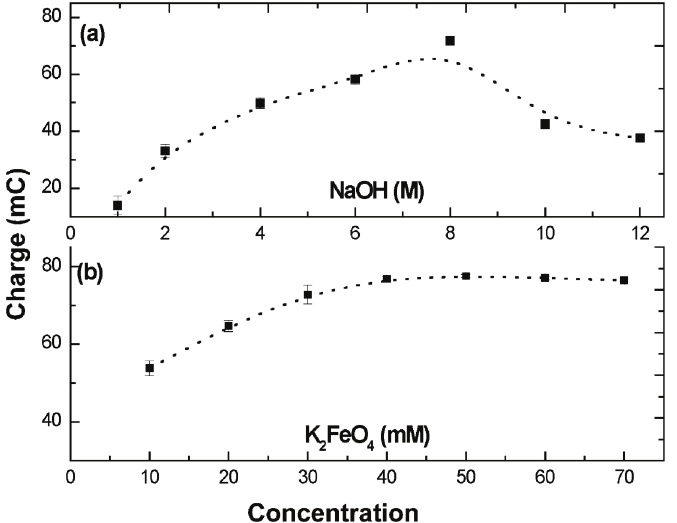
Figure 2. Electrodeposition optimization of a Fe(III/VI) film. Deposition conditions— applied potential: 110 mV versus Ag/AgCl; deposition time 10 s on a smooth platinum electrode; stirring rate: maximum, without disruptive turbulence: (a) the effect of NaOH concentration on charge storage in 50 mM K concentration on charge storage in 8.0 M